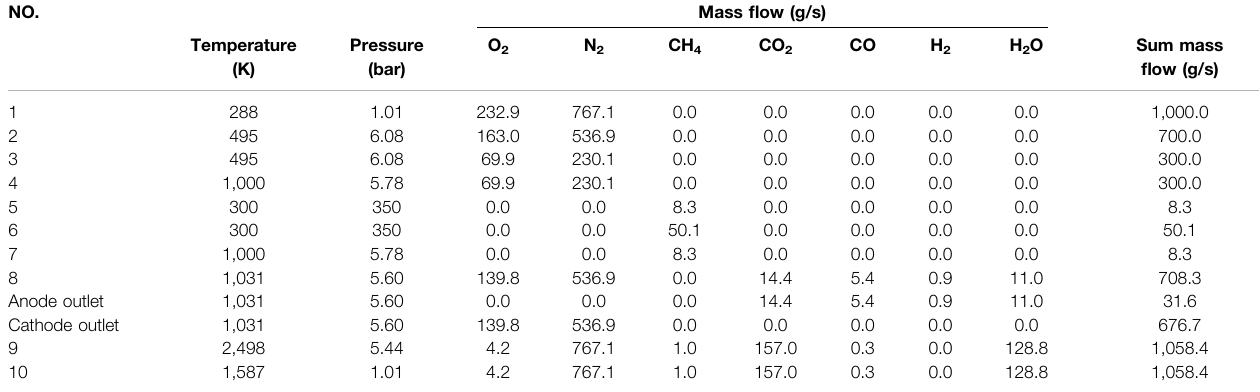
TABLE 4 | Stream data of the HEFC engine. NO.